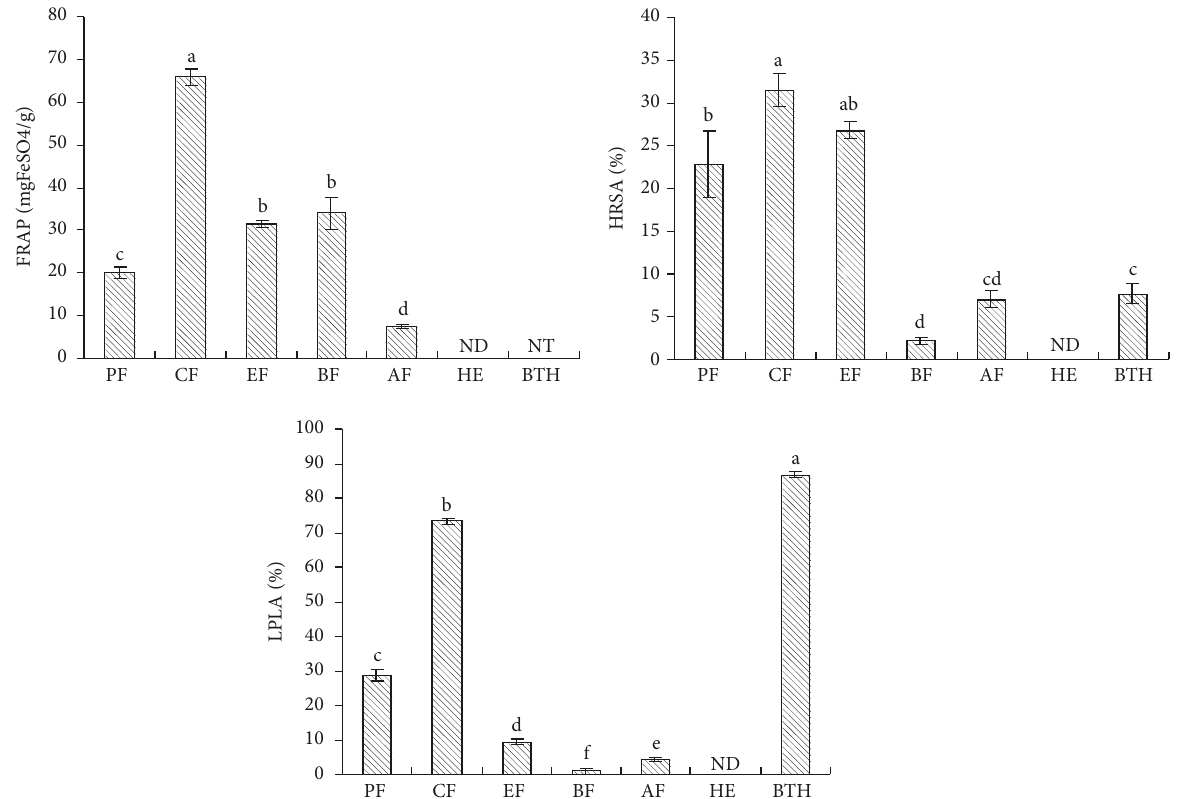
Figure 1: Antioxidant activities of the polarity fractions and hydroalcoholic extracts from maca. The values are means ± standard deviations of triplicate analyses. Columns labeled with different letters are significantly different (𝑃 < 0.01) by Duncan test. NT means not tested. ND means not